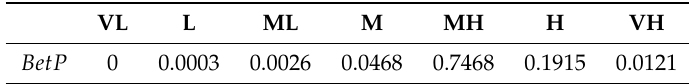
Table 10. The probability distribution of the evaluation